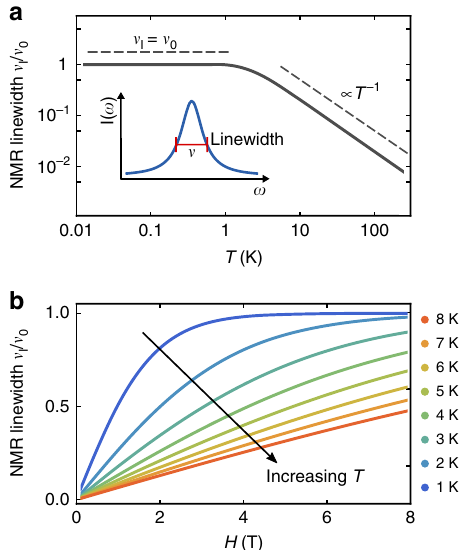
Fig. 5 Relative impurity contribution to the 13 C NMR linewidth. The relative impurity linewidth ν I / ν 0 is calculated according to Eq. (24). a ν I / ν 0 as a function of temperature T for fi xed fi eld H = 4 T. Emphasized are the constant linewidth ( ν I = ν 0 ) at low temperatures and the ∝ T − 1 scaling at high temperatures. The inset shows the linewidth de fi nition in an NMR spectrum cartoon with the intensity I as a function of frequency ω . b ν I / ν 0 as a function of fi eld H for various temperatures T . The approximately linear fi eld dependence for increasing T is in agreement with experiment